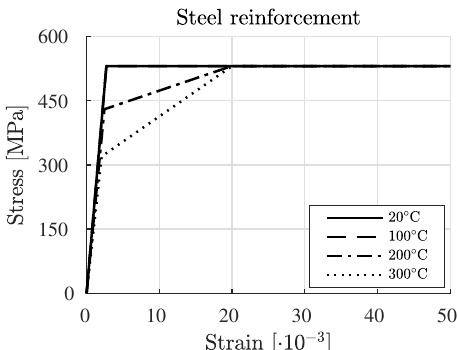
Figure 18. Temperature-dependent behavior of steel rebar subjected to uniaxial tension, as recommended by Eurocode 2.